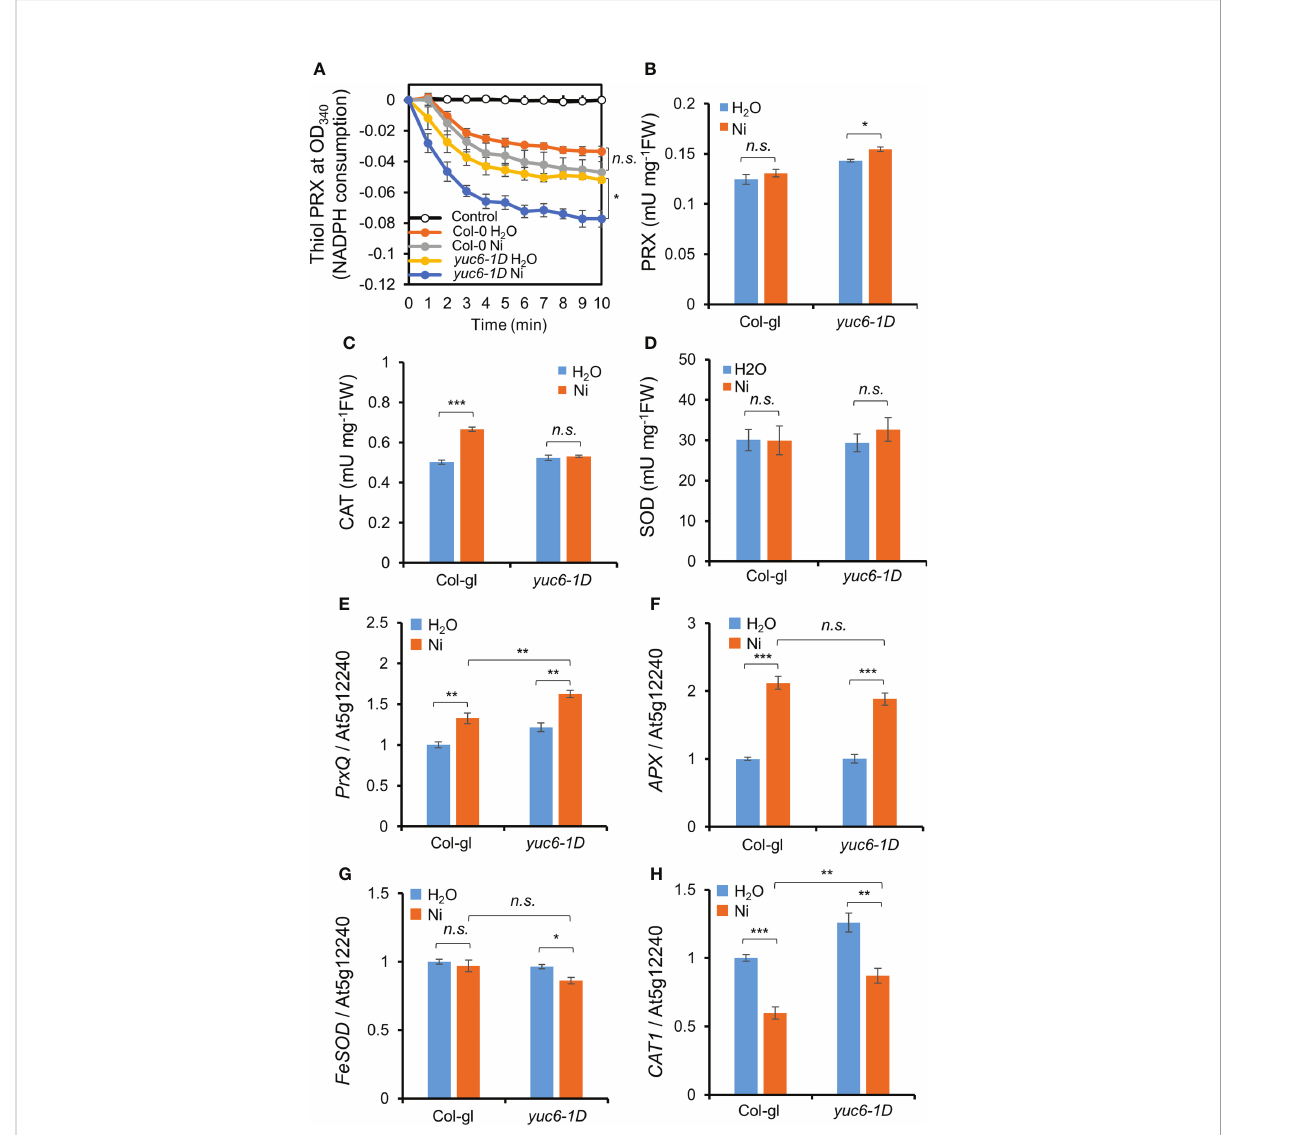
FIGURE 7 YUC6 positively regulates thiol PRX/PRX enzyme activities and PrxQ transcription. Two-week-old Col-gl WT and yuc6-1D plants were treated with or without 100 m M Ni for 12 hrs (for antioxidant enzyme activities, A – D ) or 6 hrs (for qPCR, E – H ). Thiol PRX (A) , PRX (B) , CAT (C) , and SOD (D) activities. Thiol PRX (A) was measured by the NADPH consumption at OD 340 in the presence of AtTRX-h2, AtNTRA, H 2 O 2 , and NADPH. Total proteins extracted from Col-gl and yuc6-1D with or without Ni stress were applied to the thiol PRX assay. Control is monitored without plant extracts. PRX (B) , CAT (C) , and SOD (D) activities were monitored using the plant extracts mentioned above. Transcription of PrxQ (E) , APX (F) , FeSOD (G) , and CAT1 (H) . The expression levels of antioxidant genes (E – H) were normalized to AT5G12240 . Values are means ± SE of three (A – C, E – H) or four (D) independent biological replicates. Asterisks indicate signi fi cant differences (* p < 0.05, ** p < 0.01, *** p < 0.001, and n.s. , no signi fi cant) from the H 2 O treatments in each genotype or between Ni-treated Col-gl and yuc6-1D determined by two-tailed Student ’ s t